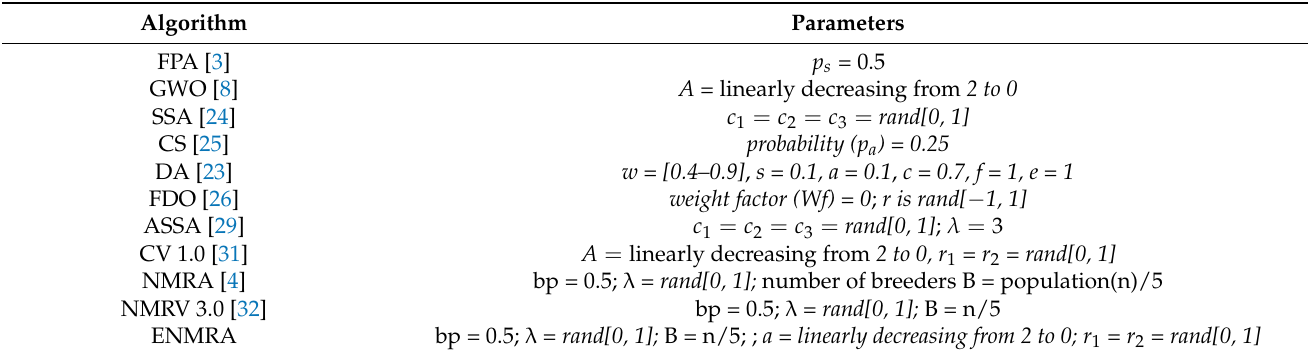
Table 1. Parameter settings of competitive